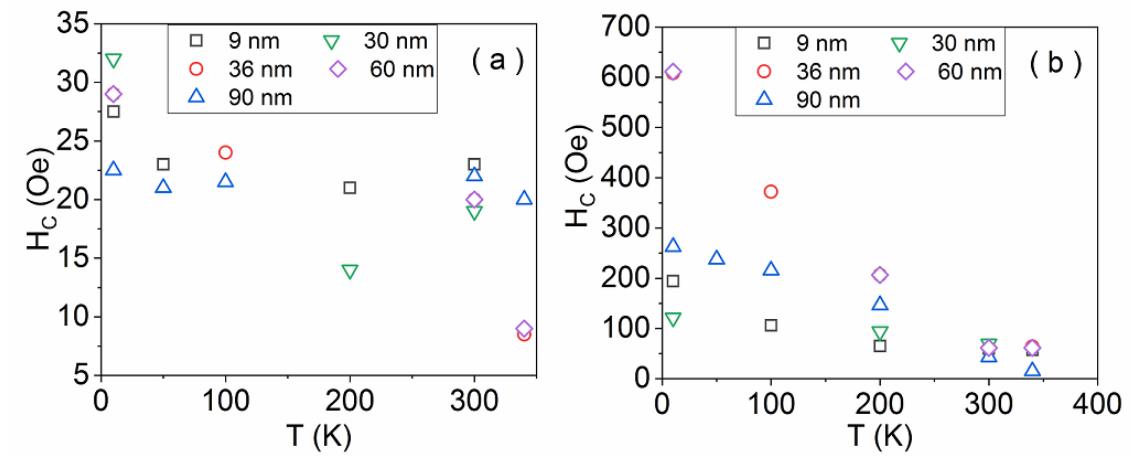
Figure 5. Temperature dependence of the coercive field of the main magnetic phase in parallel ( a ) and perpendicular ( b ) geometry for the LSMO samples.